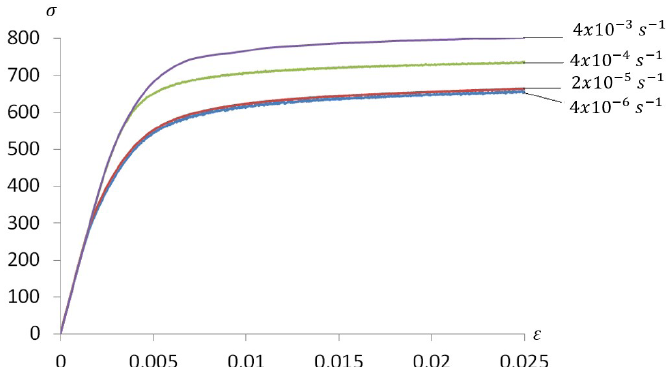
Figure 3. Experimental results of superduplex stainless steel - σ (MPa)-ε (mm/mm).